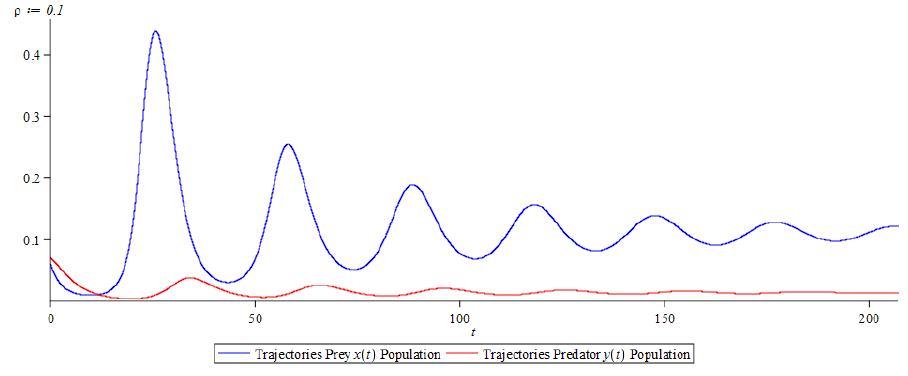
Figure 12. Fear cost trajectory